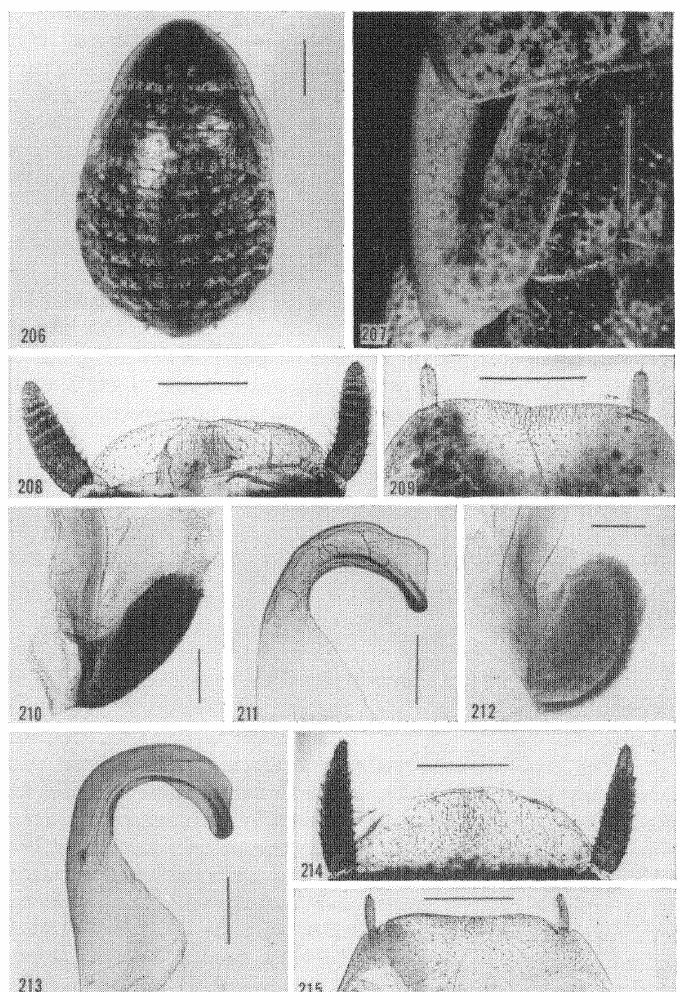
Figures 206-215. CalolamIra notabilis. 206. 9 (181 L), V. (without exact locality). 207. Tegmen ot shown in figure 206. 208-211. $ (23 SAM), Warunda, Eyrie Pen., S. A. 208-209. Supra-anal plate and hy- pandrium. 210-211. Genitalia. 212-215. $ (151 MCZ), A. (without exact locality). 212-213. Genitalia. 214-215. Supra-anal plate, and hypandrium. Scale: Fig. 206 4 mm; Fig. 207 2 mm; Figs. 208-209, 214-215 ram; Figs. 210-213 0.2